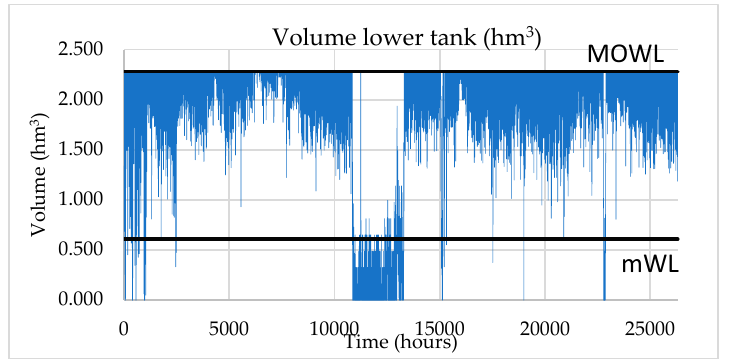
Figure 13. Behavior of the volume in the lower tank throughout the simulation, 3 years. Own source with analysis of results.